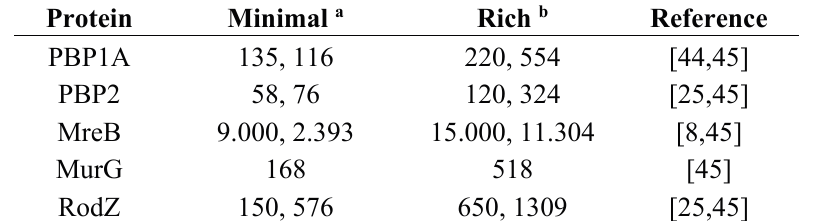
Table 1. Reported protein copy numbers per cell in different growth